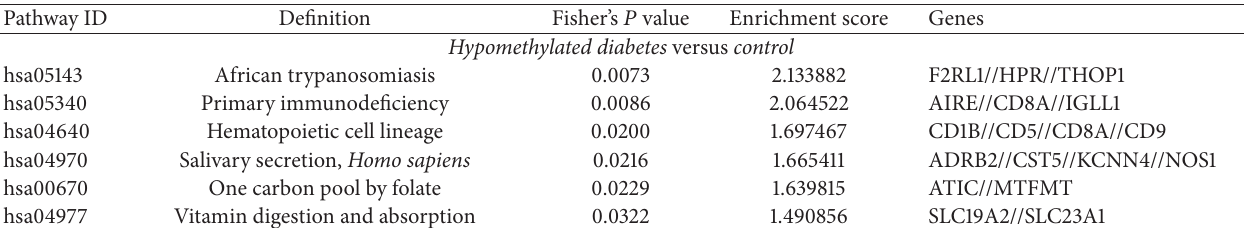
Table 2: KEGG analysis of top ten enrichment score ( − log 10 ( 𝑃 value)) values of the significant enrichment